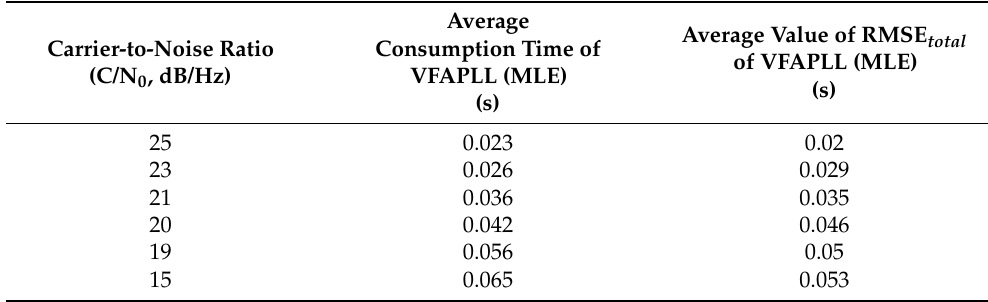
Table 1. The average consumption time and Average value of RMSE total of VFAPLL (MLE) when CNR is 15, 19, 20, 21, 23, and 25 dB/Hz.